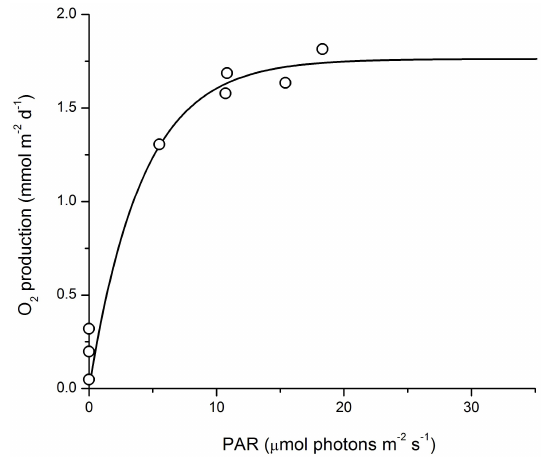
Fig. 6. P/I curve calculated by fitting Eqs. 3 and 4 simultaneously ( R 2 = 0.923) to the averaged O 2 fluxes in Fig. 5a. The open circles represent the GPP determined from the averaged fluxes in Fig. 5A. This P/I curve had an I k value of 4.2µmol photons m − 2 s − 1 which represents the point where light saturation begins to